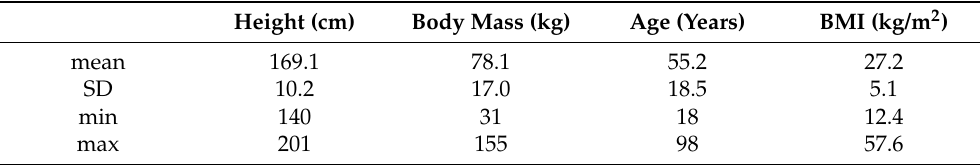
Table 3. BMI of adult patients operated on in the Department of Orthopedic Surgery and